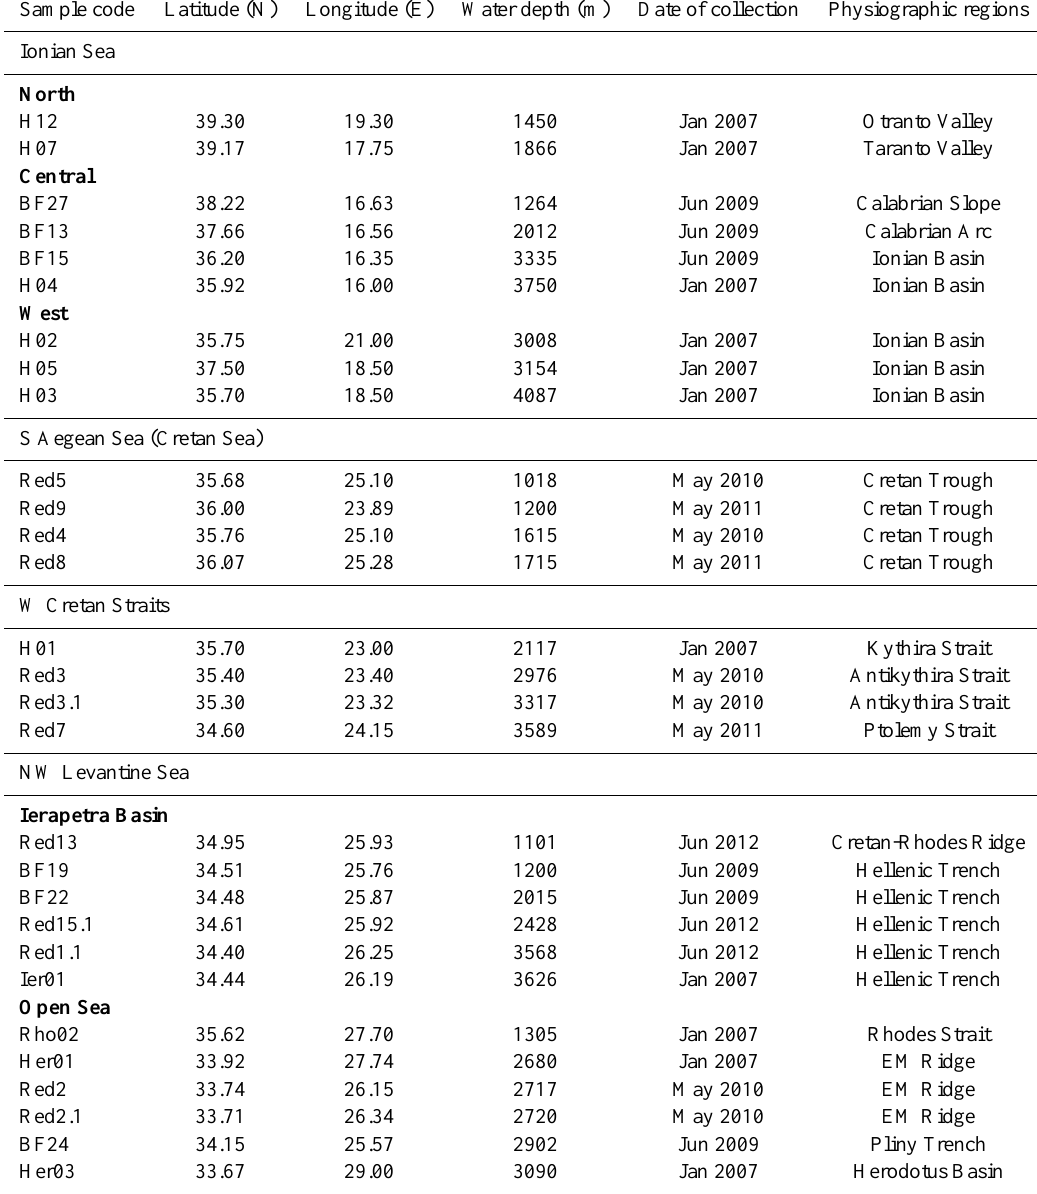
Table 1. Location, depth and collection date of sediment